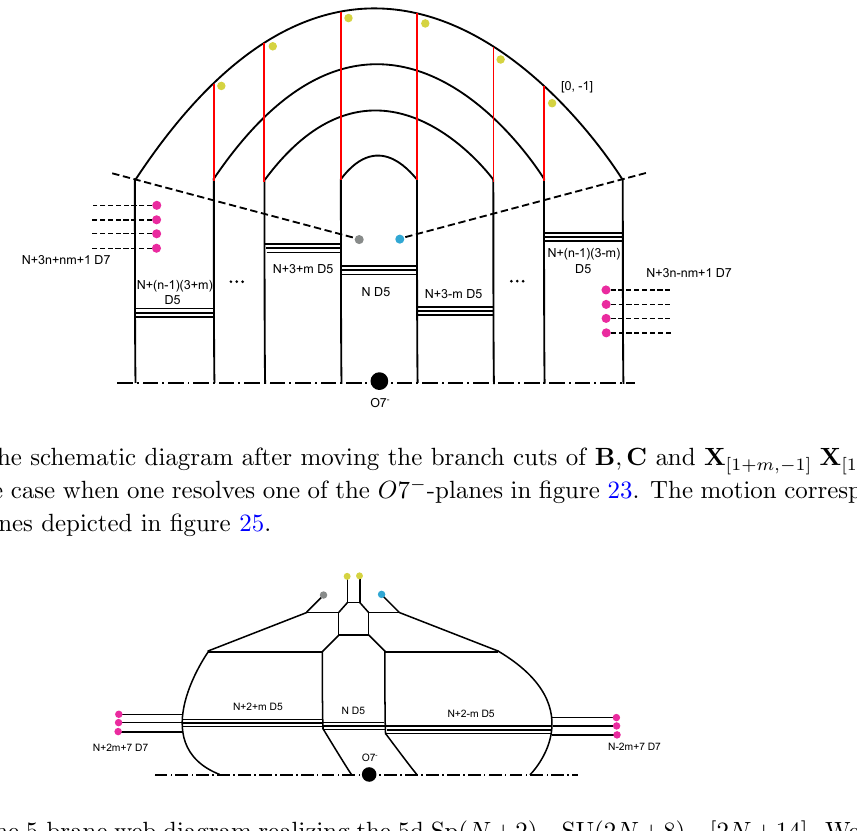
SU(2 N +8) [2 N +14]. We only (cid:0) (cid:0)